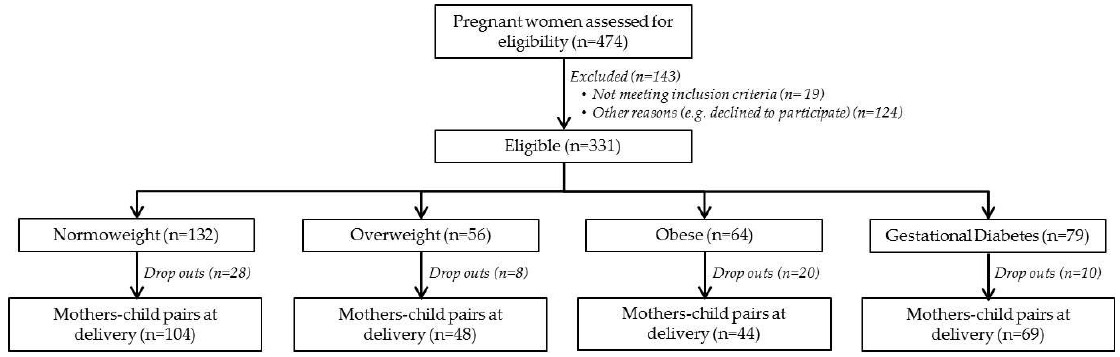
Figure 1. Participants in the PREOBE cohort and classification following BMI and gestational diabetes criteria.